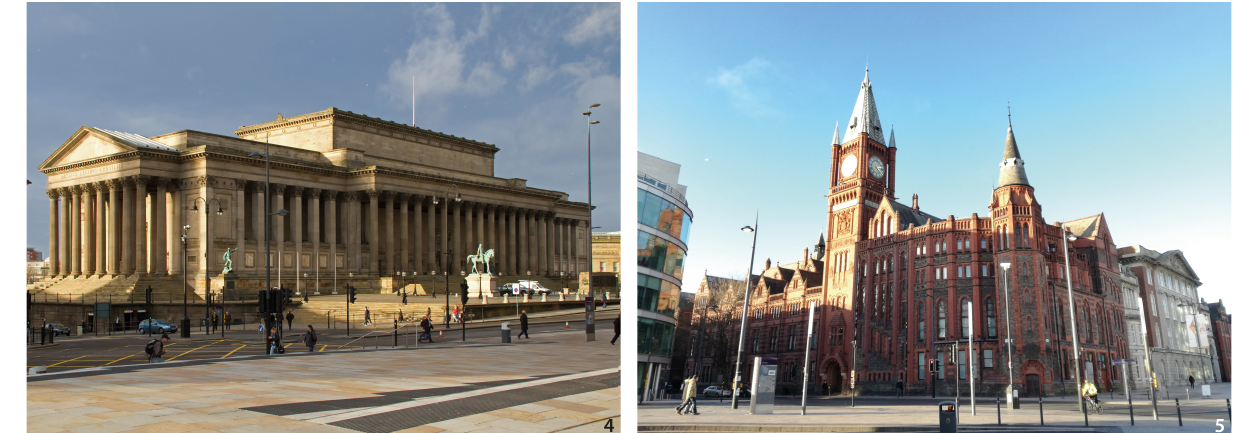
Figure 4 The restored St. George’s Hall (Source: Tony Hisgett, Flickr, https://www.flickr.com/photos/hisgett/6727529617/). Figure 5 The Victoria Gallery and Museum (Source: the